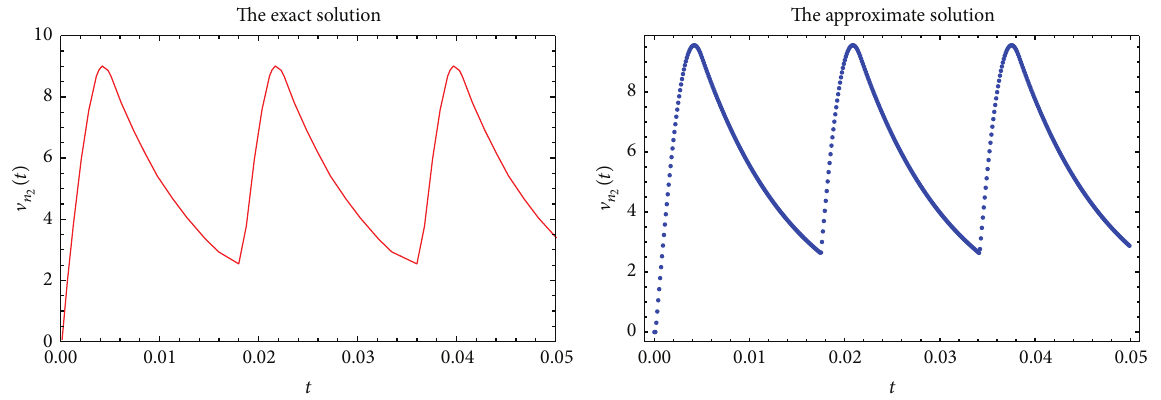
(𝑡)) of the diode circuit. 2